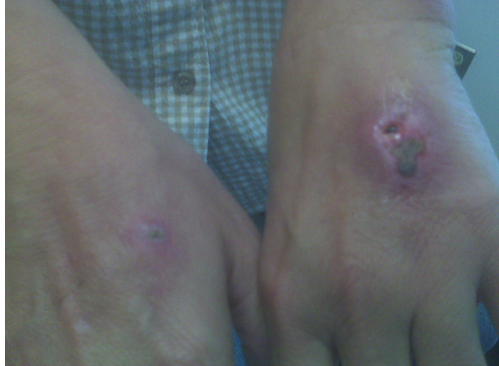
Figure 2: Ulcerative, nodular wounds on the dorsum of bilateral hands where patient sustained dog bites. Left hand is worse than right.